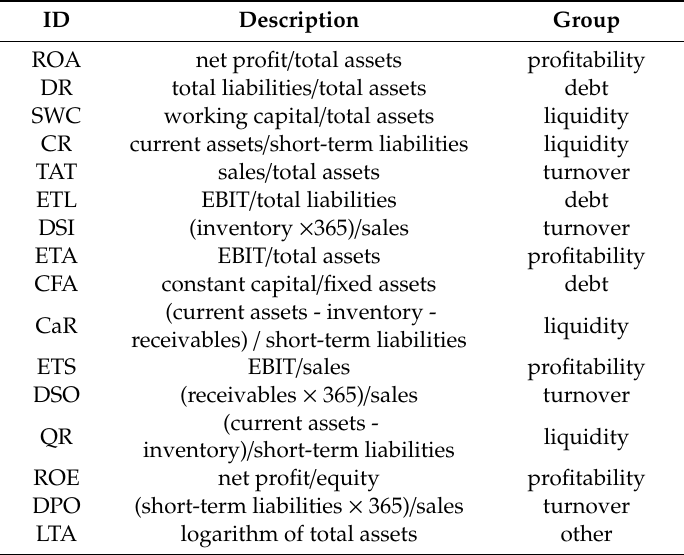
Table 3. Set of chosen ratios considered in the